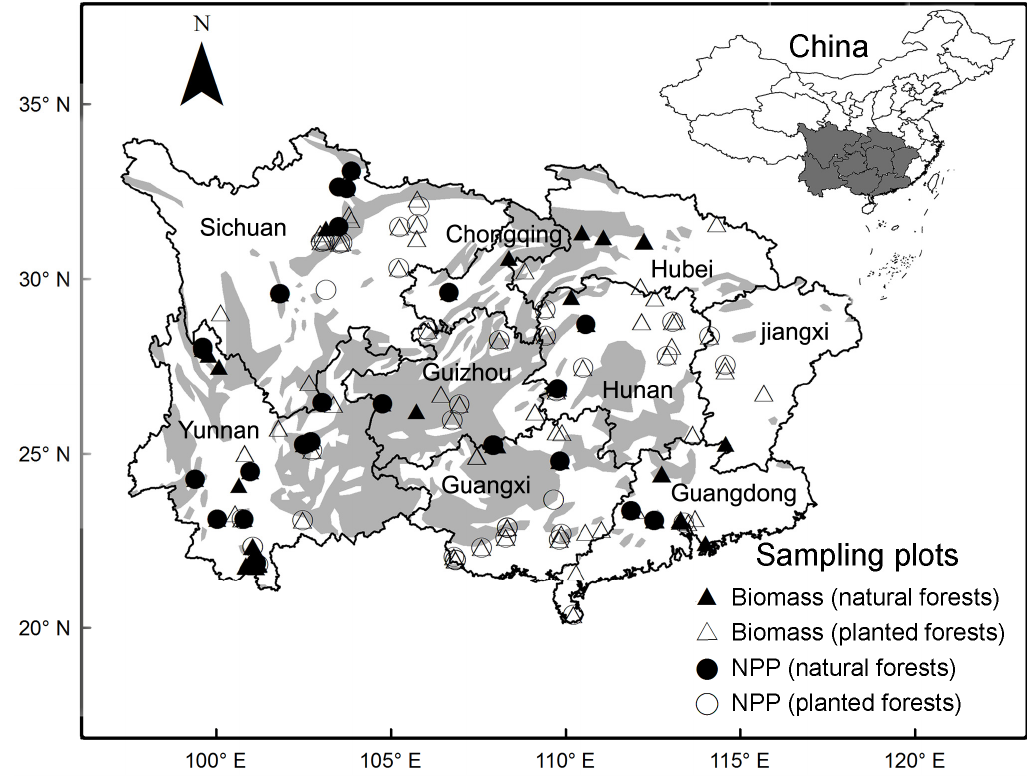
Figure 1. Locations of biomass and NPP sampling plots in the distribution map of karst terrain (the grey) in Southwestern China.